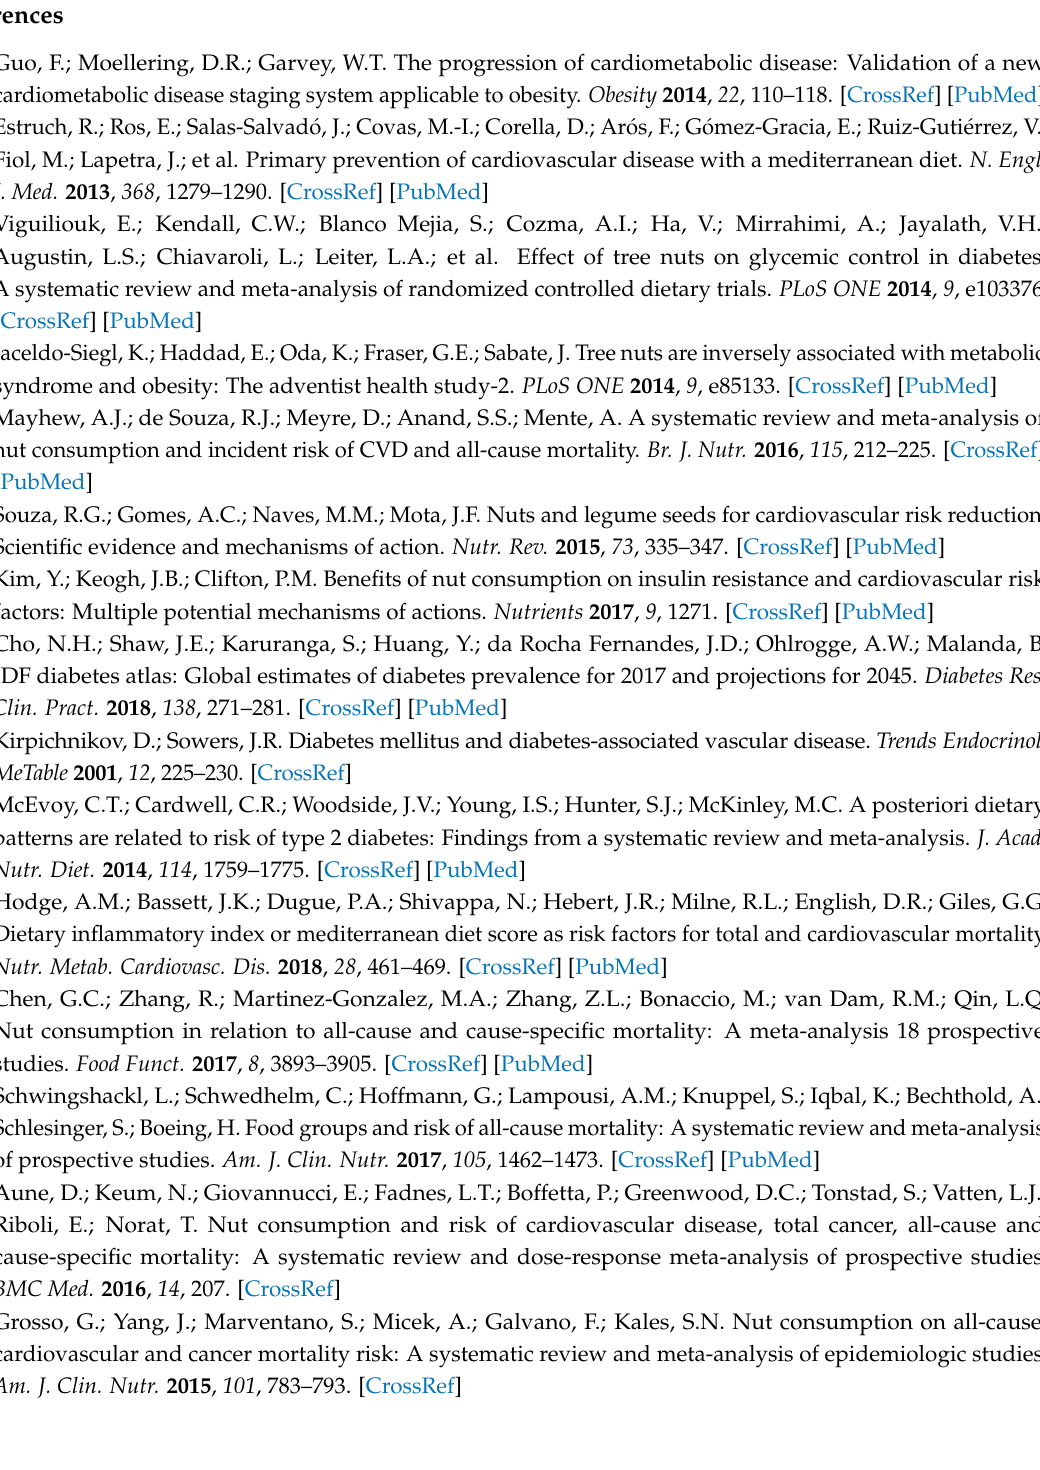
Figure S40. Nuts and vascular cell adhesion molecule-1 (VCAM-1), Figure S41. Nuts and E-selectin, and Figure S42. Nuts and flow-mediated dilation